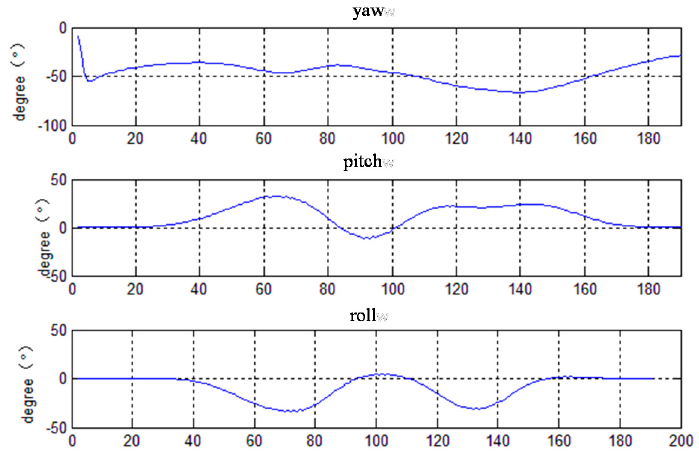
Figure 16. Curve of angles of posture.